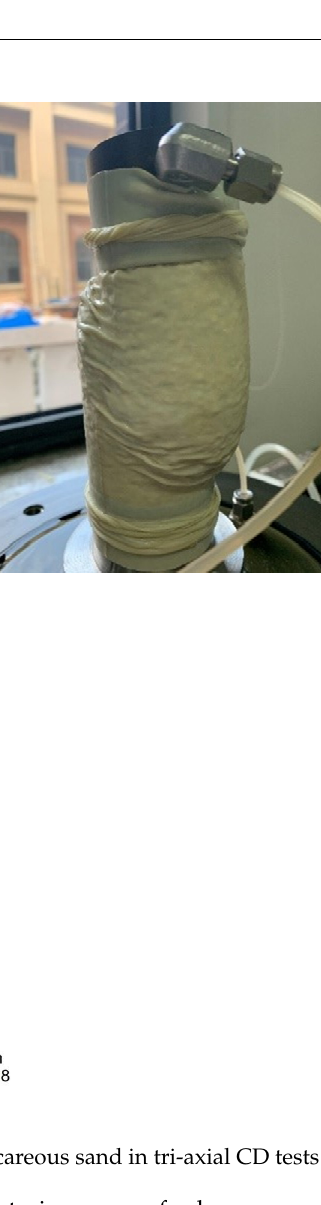
Figure 9. Effective stress–axial strain ratio curve of calcareous sand in tri-axial CD tests.